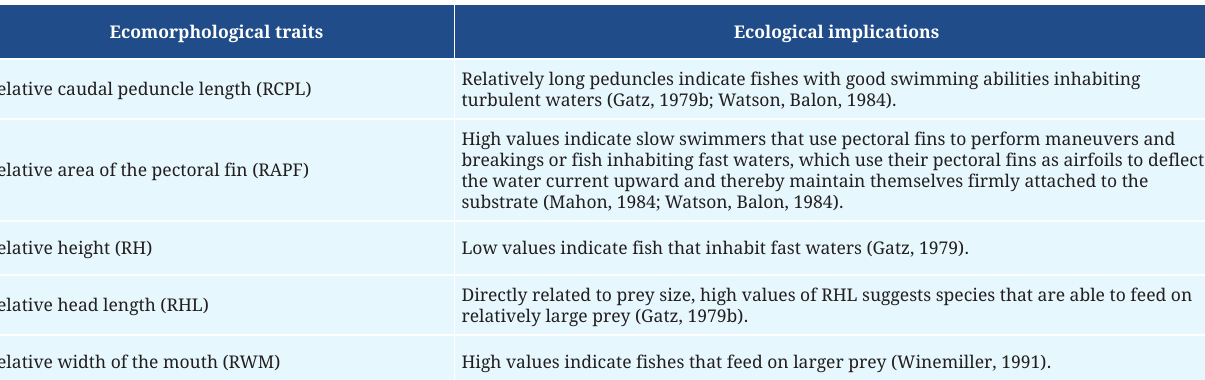
TABLE 1 | Ecomorphological traits and their ecological implications related to body size, vertical (water column) and lateral (marginal and central) habitat, and resource